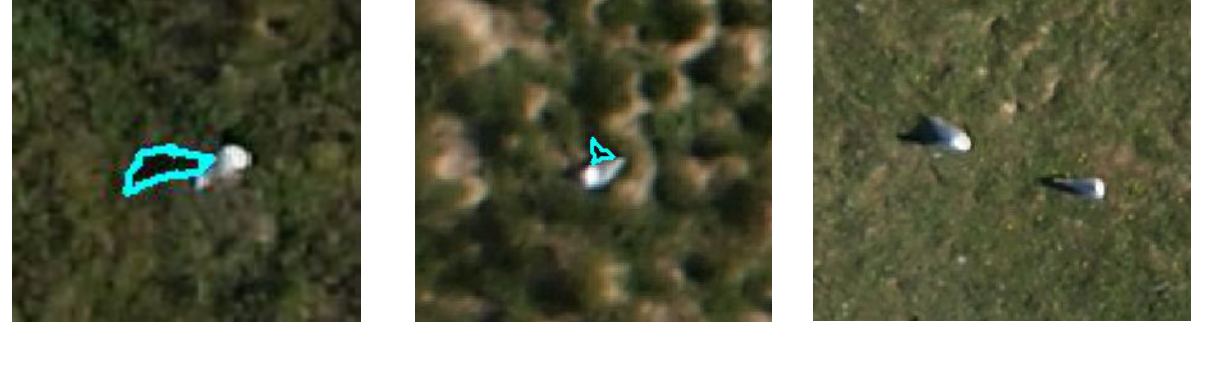
Figure 4c. incorrectly classified standing birds (Unfavorable orientation, ie, small